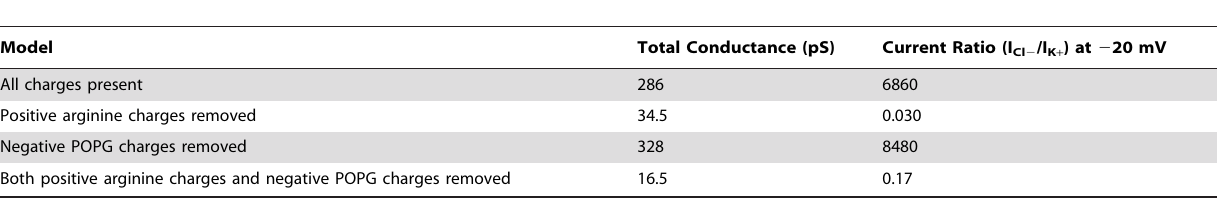
Table 3. Effects of various charged moieties in the system on conductance